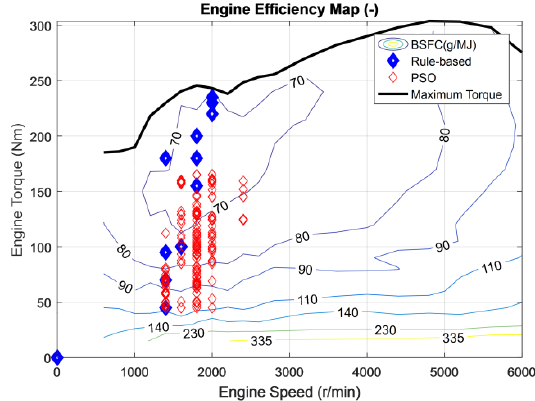
Figure 17. Comparison of electric conversion loss in the highway driving cycle.